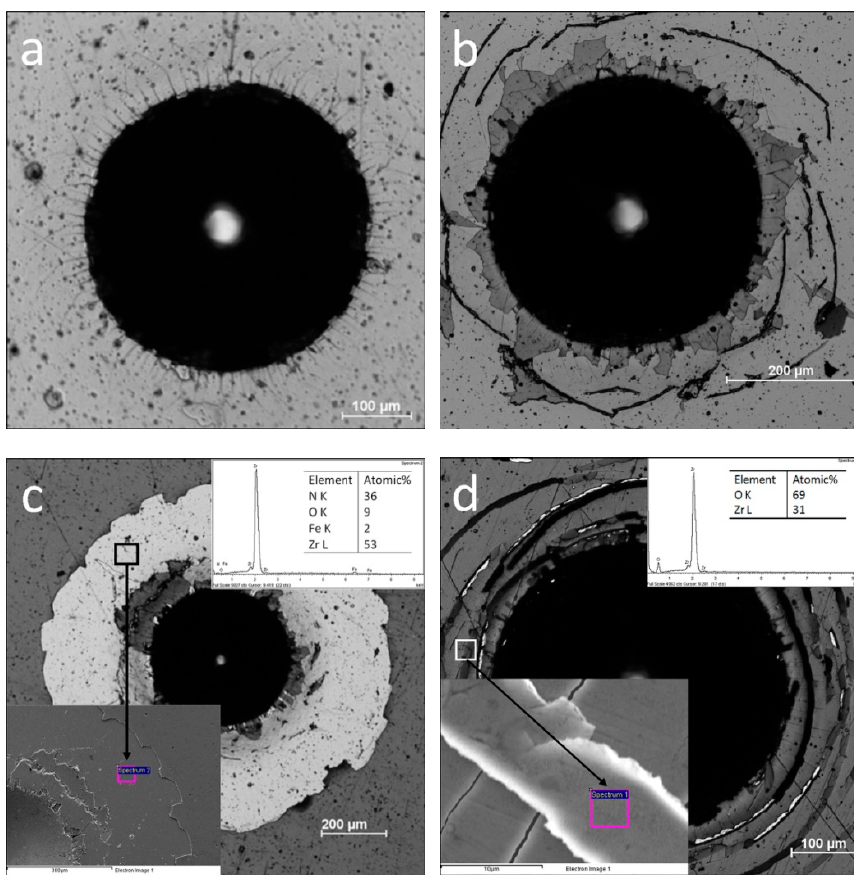
Figure 12. Micrograph of the indentation morphology in Rockwell test: ( a ) ZrO(0)N, ( b ) ZrO(10)N, ( c ) ZrO(20)N, and ( d ) ZrO(100)N. ( c ) ZrO(20)N, and ( d )